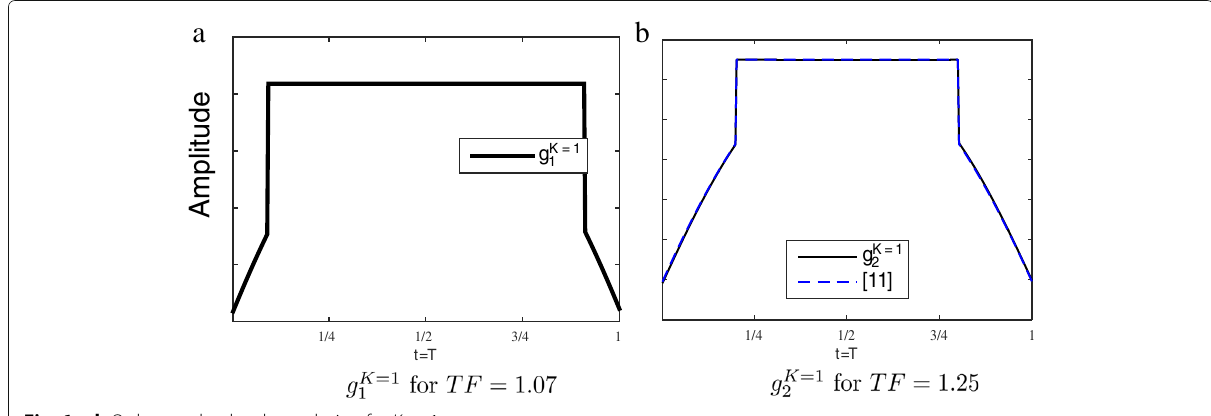
Fig. 6 a , b Orthogonal pulse shape design for K = 1